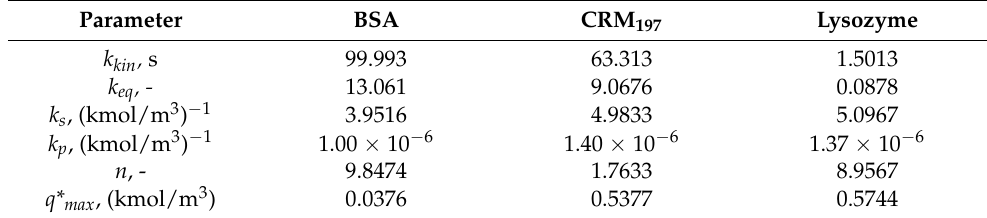
Figure 7. Comparison of experimental and simulated bind-elute tests for BSA, CRM 197, and Lysozyme. On the left the gradient elution and on the right the isocratic elution. The thinner black line is the normalized conductivity signal, the dotted line is the simulated outlet salt concentration. The black peak is relative to the experimental protein concentration, the blue line is the simulated protein concentration when the exponential Langmuir is used, and the green line is the simulated outlet protein concentration when the power Langmuir law is used in the in-house predictive code. In the case of Lysozyme, the green line refers to the eluted peak when the linear model is used. Table 8. Parameter values for Mollerup et al. model estimated by